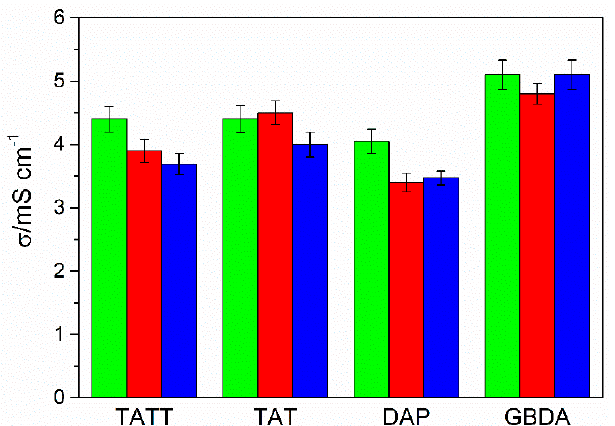
Figure 8. Ionic conductivity of investigated ionogels obtained by photopolymerization of thiols TMPTP (green columns), PETMP (red columns), and PETMB (blue columns) with different allyl monomers: TATT, TAT, GBDA, and DAP. RSD ≤ 5%.